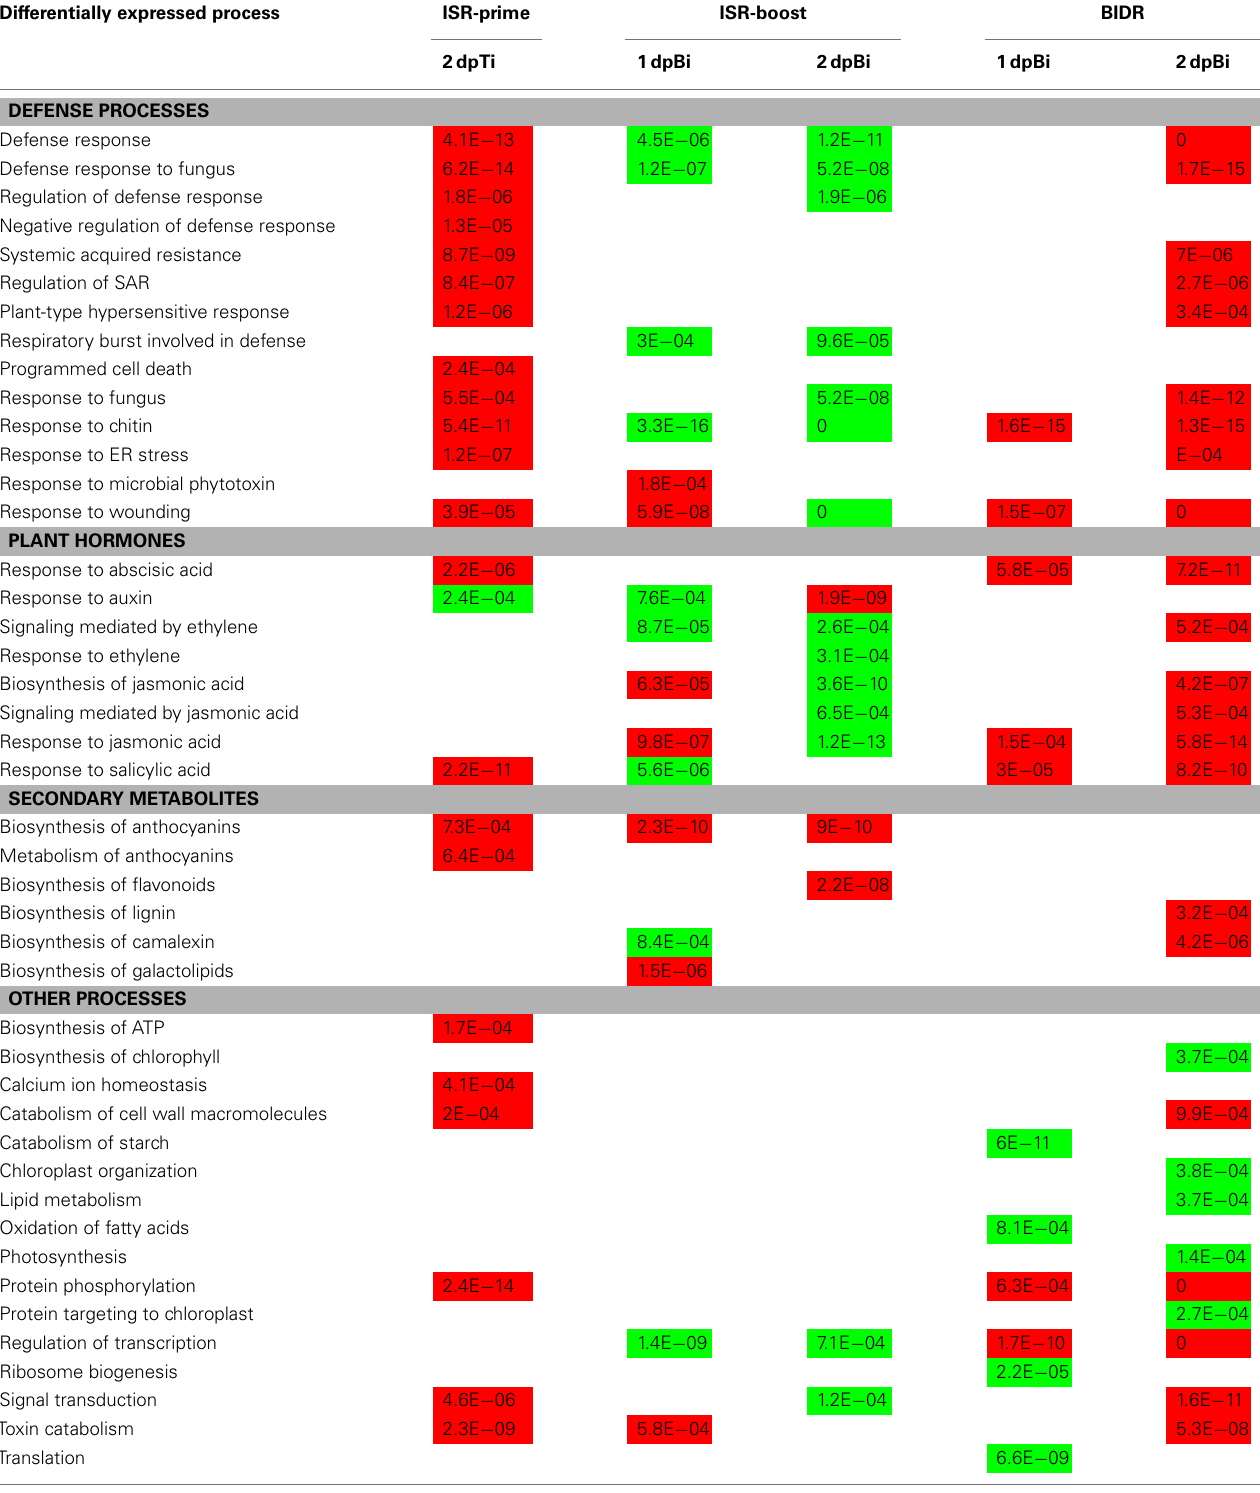
Table 2 | Differentially expressed biological processes enriched ( p < 0.001) during ISR and BIDR. Differentially expressed process ISR-prime